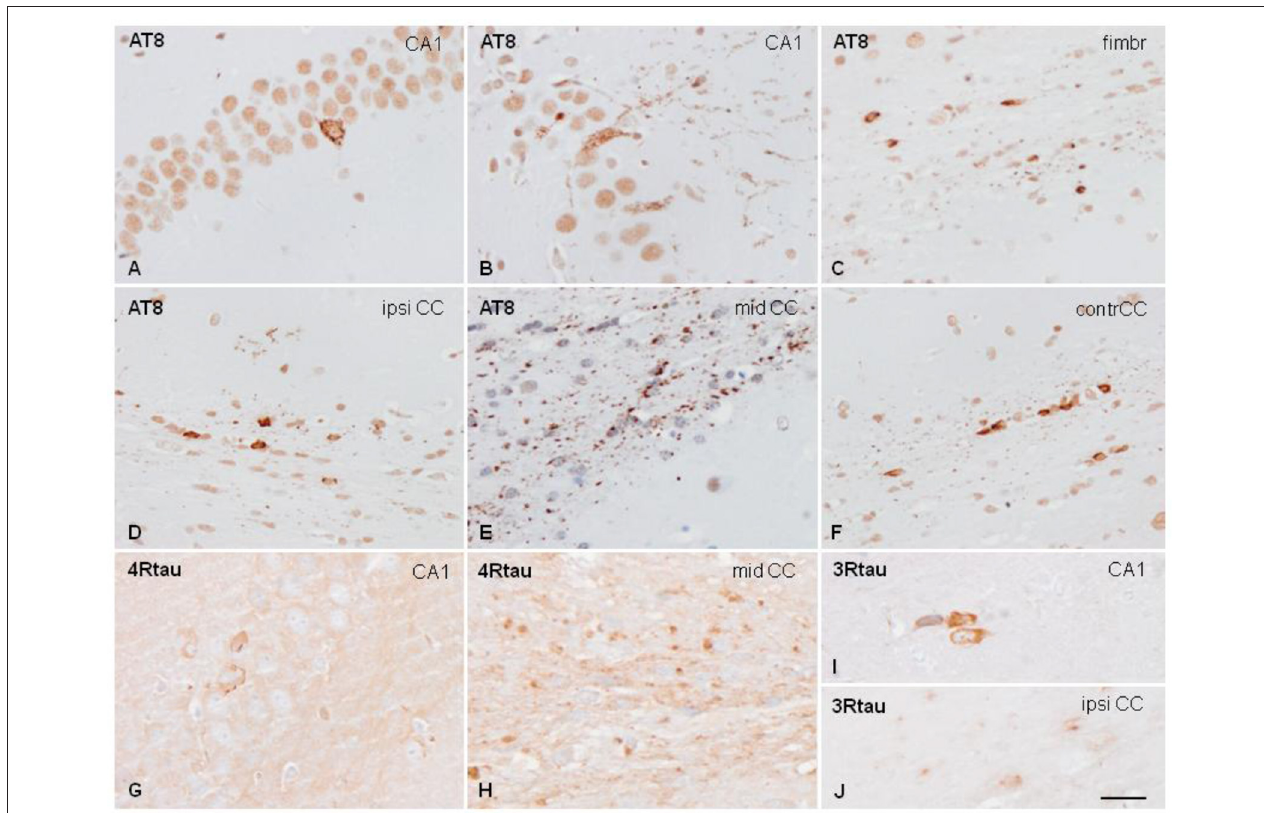
FIGURE 4 | Hyper-phosphorylated tau-containing cells and threads following unilateral intra-hippocampal injection of sarkosyl-insoluble fractions from PART into WT mice at the age of 7 months and killed at the age of 10 months (3 months survival) (A,C) ; 3 months and killed at the age of 10 months (C,D–F) ; and at the age of 12 months and killed at the age of 19 months (7 months survival) (G–J) . Tau deposits in neurons, independently of the survival time, show granular deposits in the cytoplasm, and occasional denser inclusions with no similarities with tangles (A,B) . Threads and coiled bodies are abundant in the fimbria and corpus callosum (C–F) . Individual neurons, threads and oligodendrocytes in inoculated mice are stained with anti-4Rtau (G,H) and anti-3Rtau (I,J) antibodies. Paraffin sections slightly counterstained with hematoxylin. CA1, region of the hippocampus; fimbr, fimbria; ipsi contr CC, ipsi- and contralateral corpus callosum; (A–F) , bar = 50 µ m; (G–J) , bar = 50 µ